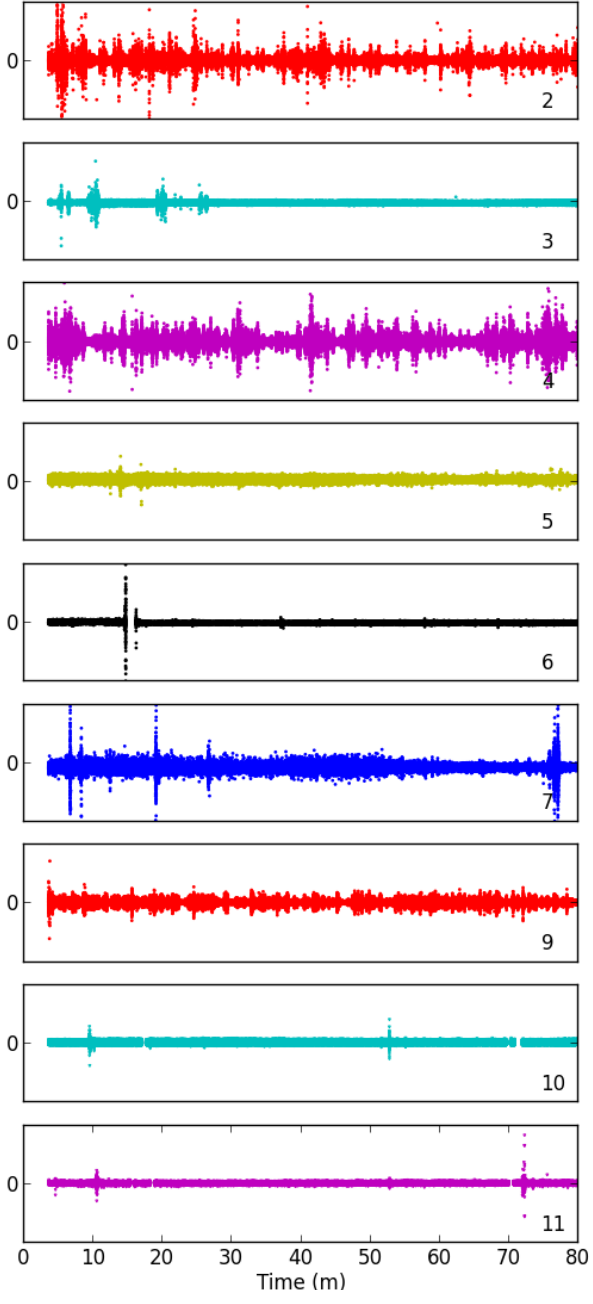
Fig. 24: Recorded seismic signals Fig. 25: Percentage of received samples over 10s intervals